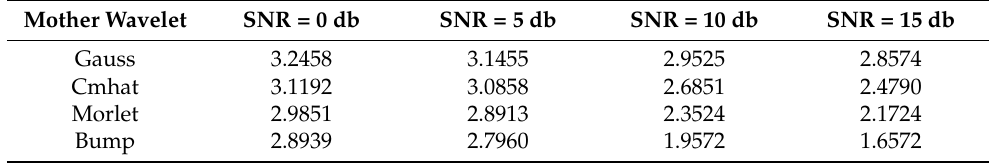
Table 2. Comparison of Rayleigh entropy when SSWT is applied with different mother wavelets. Mother Wavelet